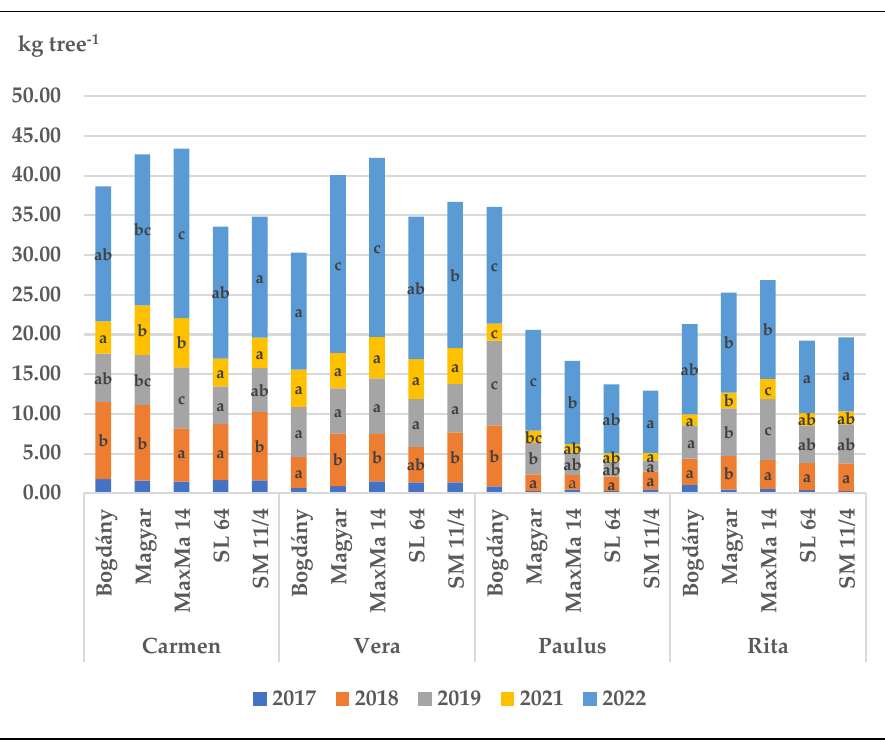
Figure 3. Cropping of trees from the third to the sixth leaf of trees (2017 to 2022). Means are separated by Tukey’s test; values with different letters within variety indicate significant differences at p ≤ 0.05 .